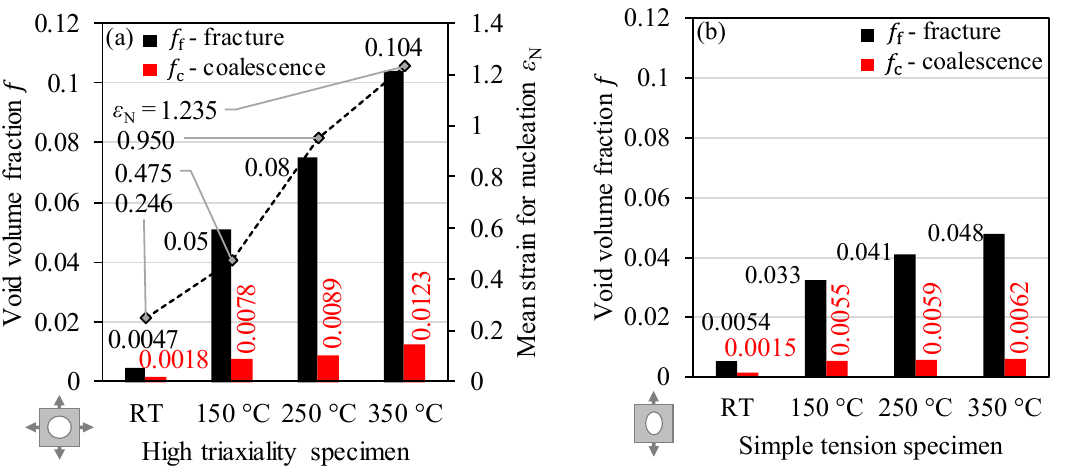
Figure 8. Gurson–Tvergaard–Needleman (GTN) model-based material parameters for critical void volume fractions for fracture and the onset of void coalescence, as well as mean strains for nucleation at RT, 150 °C, 250 °C, and 350 °C for ( a ) a high-stress triaxiality specimen and ( b ) a simple tension specimen.